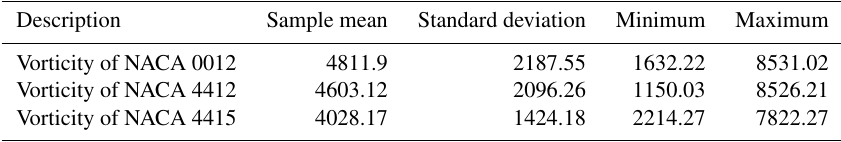
Table 4. Data variables for vorticity.